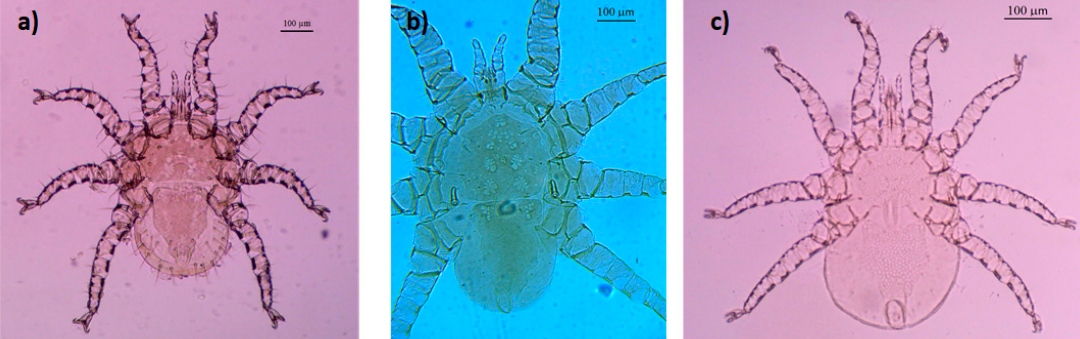
Figure 2. Female mite species from Columba livia domestica and Streptopelia decaocto : ( a ) Mesonyssus melloi ; ( b ) Mesonyssus columbae ; ( c ) Mesonyssus streptopeliae .